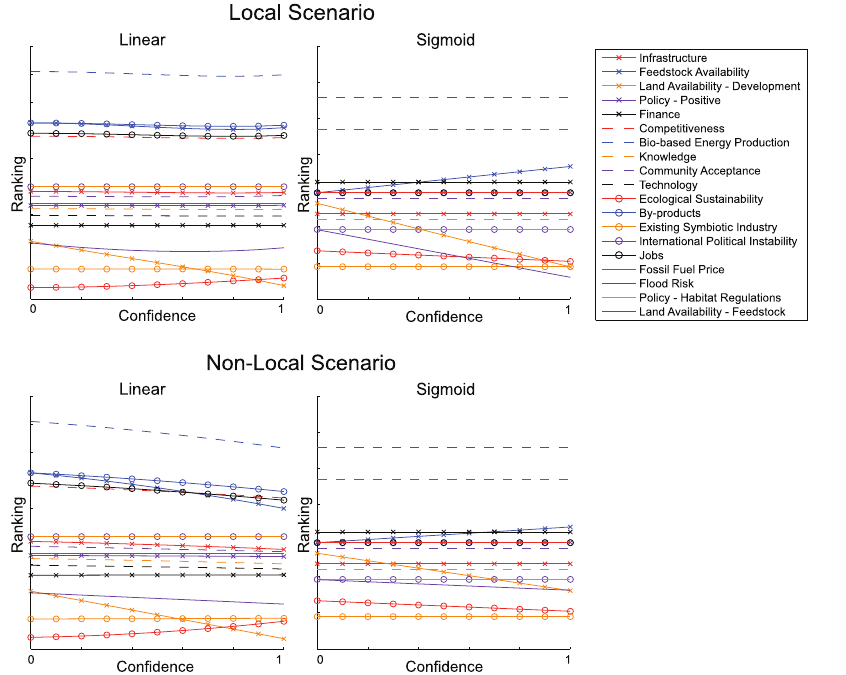
Figure 7. Results of phasing in the extra links and factors associated with the local and non-local land use scenarios. Figures show ranking of factors at a stable fixed point using either a linear or a sigmoidal map as a function of confidence (see text).